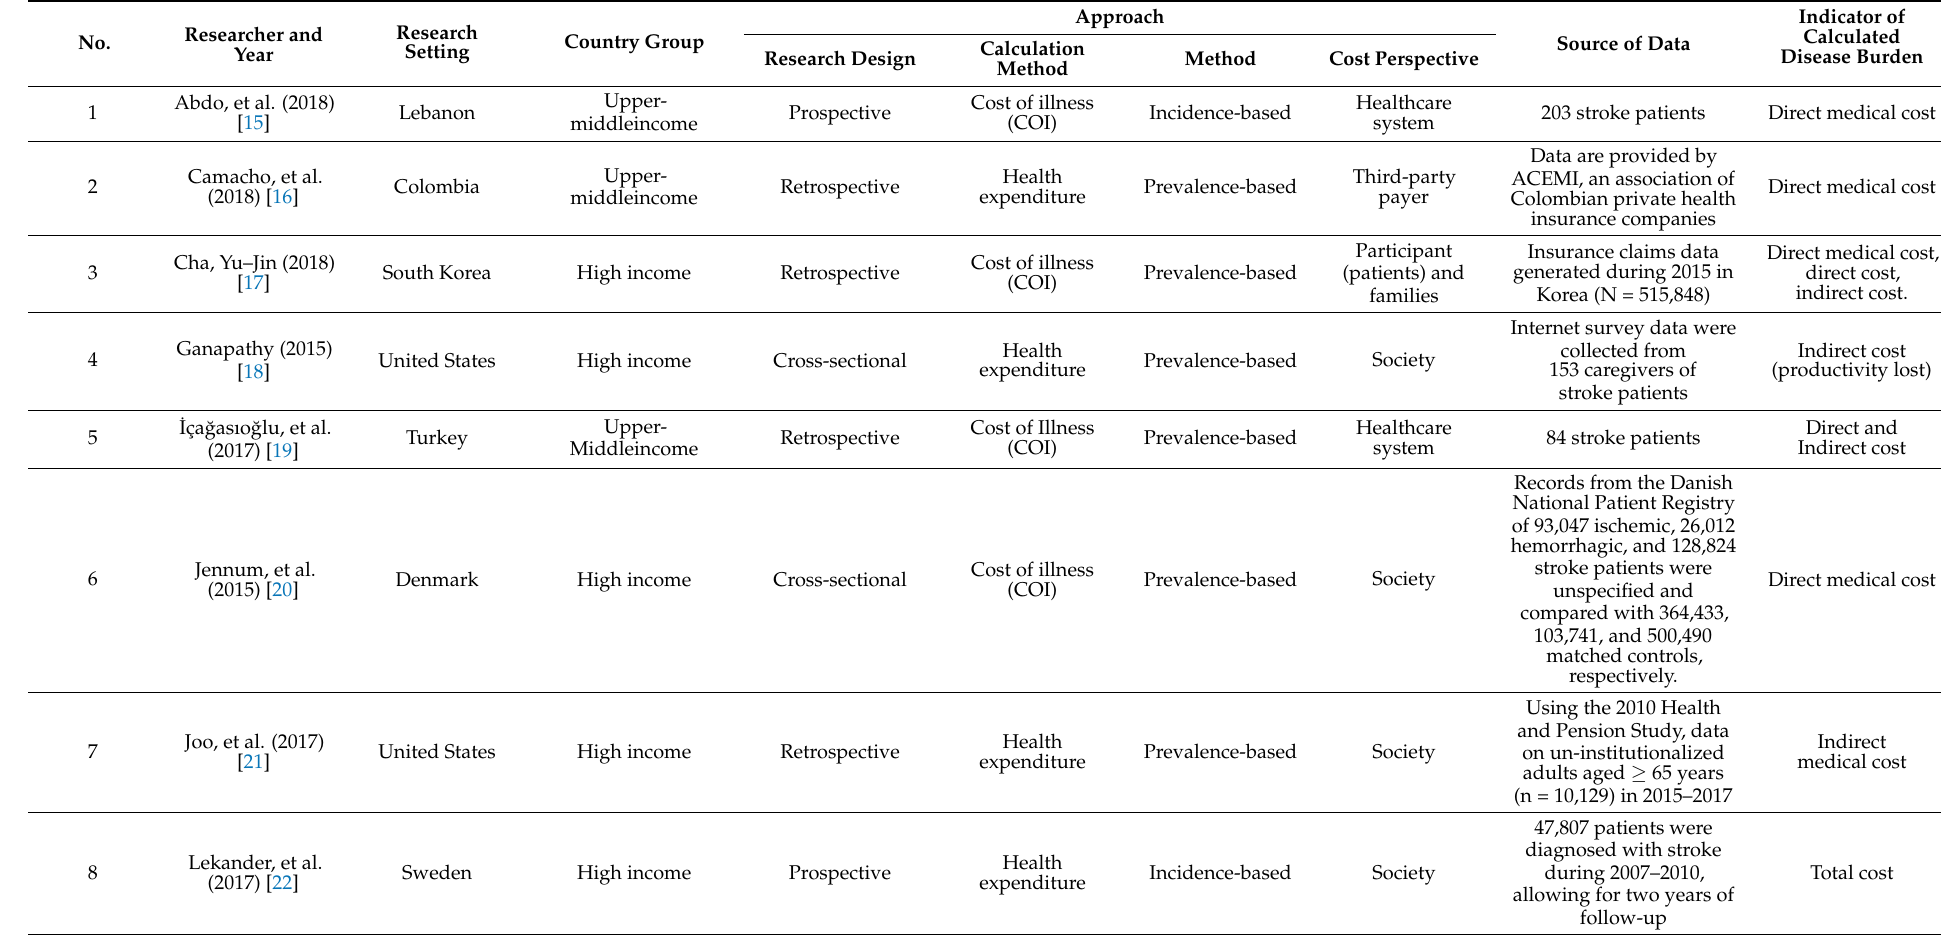
Table 1. A summary of the indicators of disease burden studied in selected articles ( n =